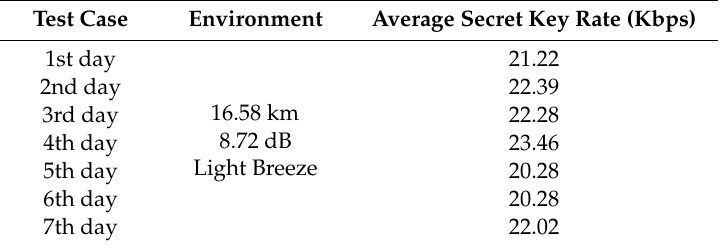
Table 6. Stability Table 6. Stability test.